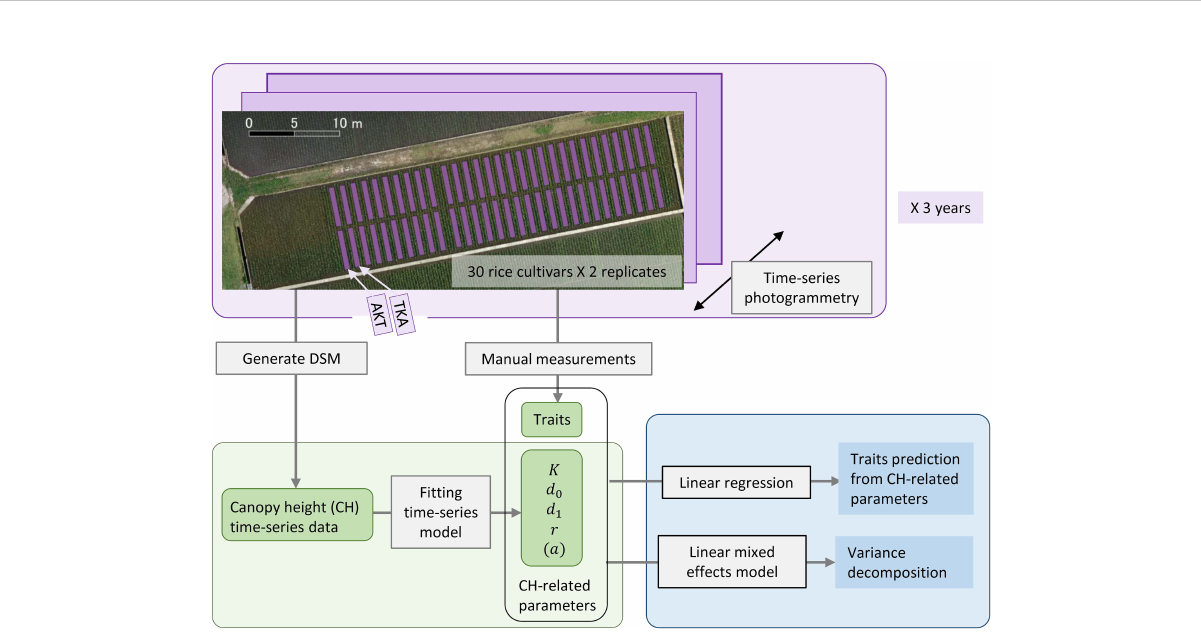
FIGURE 1 Framework of our analysis for the traits prediction from CH-related parameters. Thirty rice cultivars including AKT and TKA were grown with 2 replicates in 2019, 2020, and 2021. Aerial photogrammetry was conducted weekly. CH time-series data were obtained by generating a DSM and CH-related parameters were calculated. Several traits were measured by hand. Statistical analysis included linear regression for the traits prediction and linear mixed effects modeling for the variance decomposition of the traits and CH-related